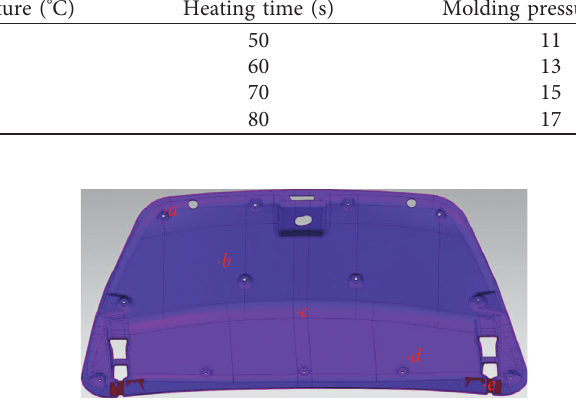
Figure 16: Measurement points for maximum thinning rate and thickening rate.